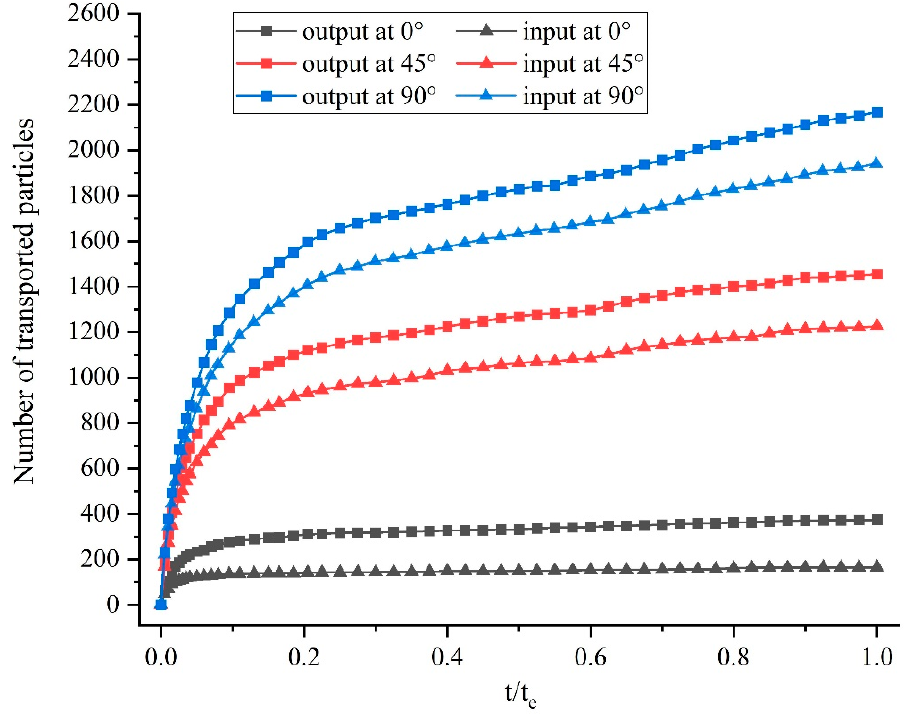
Figure 15. Sediment input and